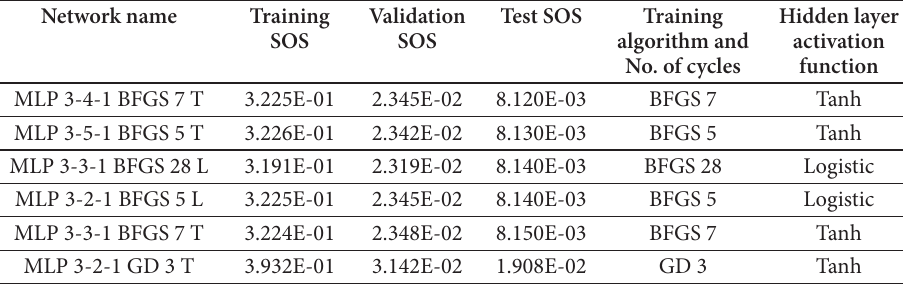
Table 3. Neural Networks’ results on Romanian